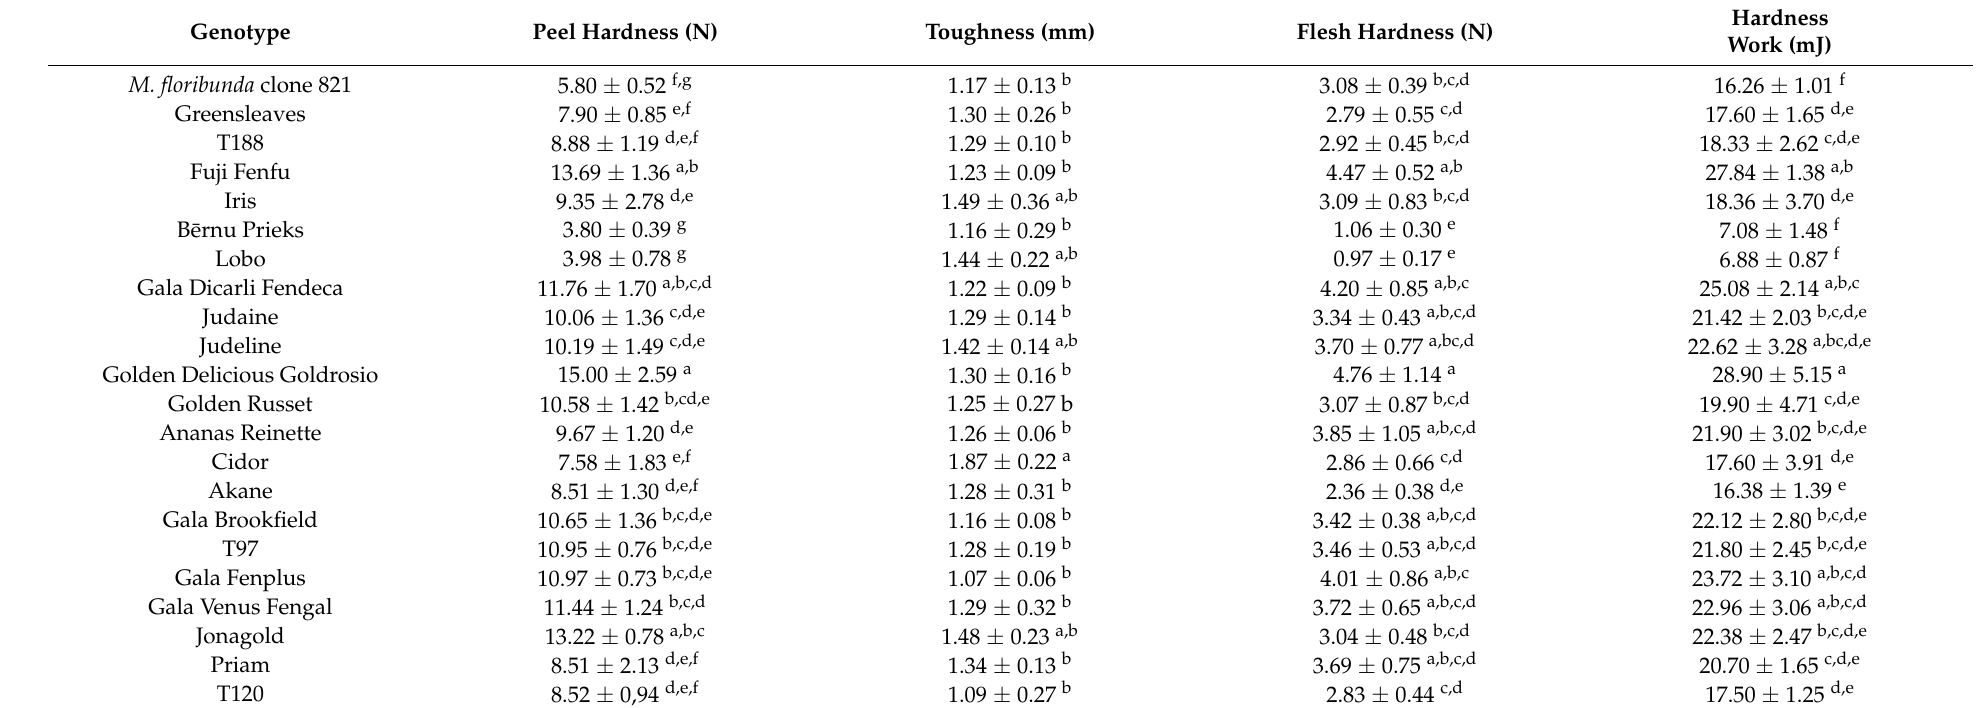
Table 5. Comparison of peel hardness, flesh hardness, toughness, and hardness work of 22 apples